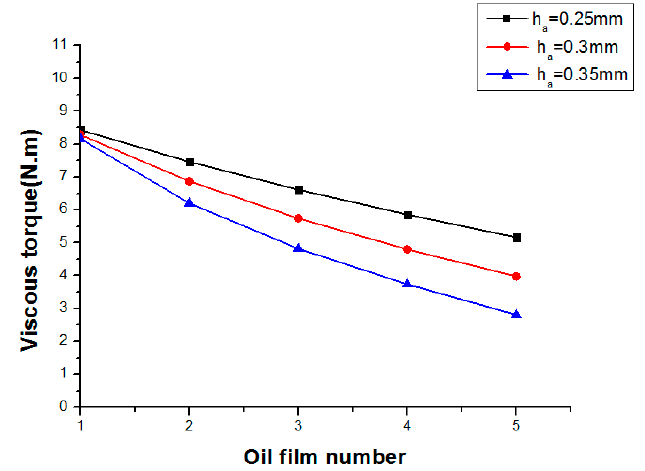
Figure 5. Viscous torque distribution with different h a . Under the situation of h a = 0.3, K 3 / K 1 = 0.1, given K 2 = 1.5, 2, 2.5, the relationship between viscous torque, oil film thickness, and the oil film number is shown in Figures 6 and 7.